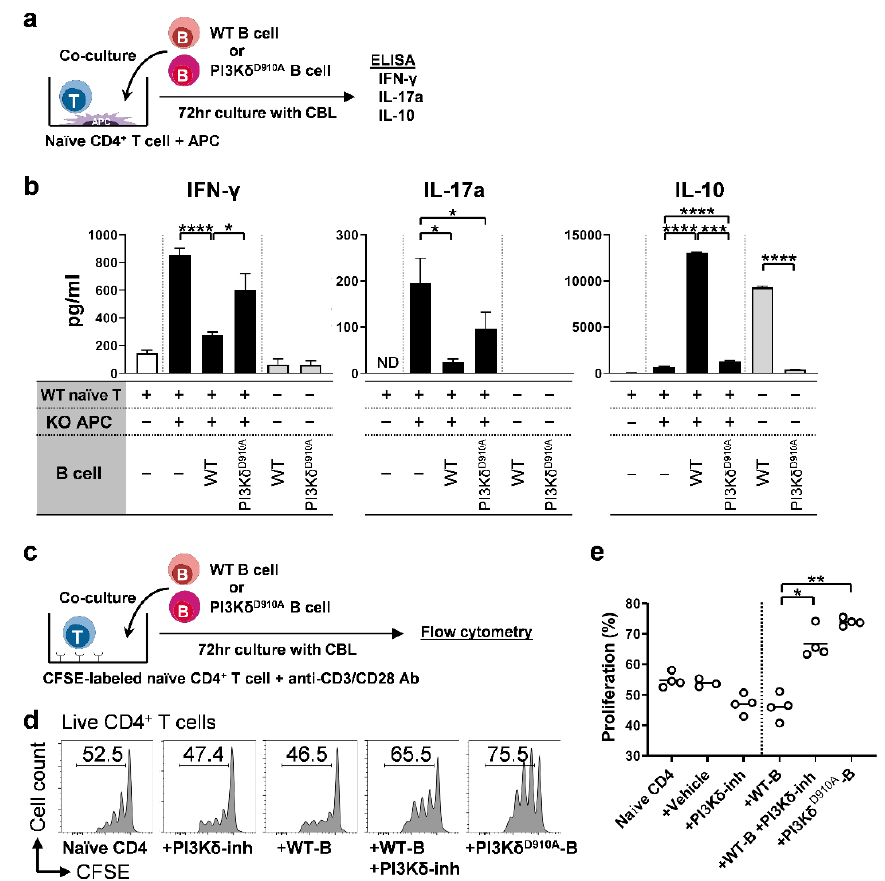
Figure 5. PI3K δ -signaling in B cells regulates bacteria-stimulated inflammatory cytokine production by and proliferation of T cells. ( a , b ) 5 × 10 5 WT splenic naïve CD4 + T cells plus 2 × 10 5 Il10 − / − ; Rag2 − / −